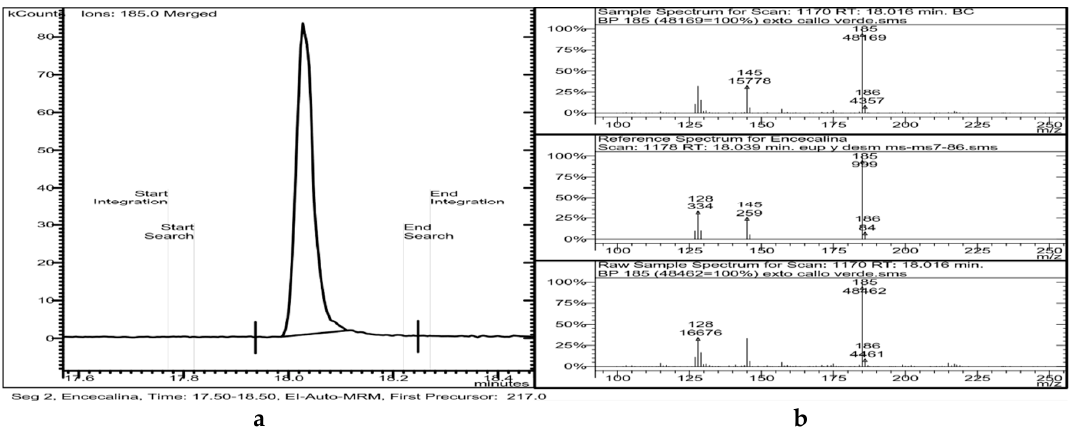
Figure 7. ( a ) Chromatogram of a sample of callus where the peak of encecalin can be seen, as well as ( b ) mass spectrum obtained by fragmentation of the precursor ion of mass 217.